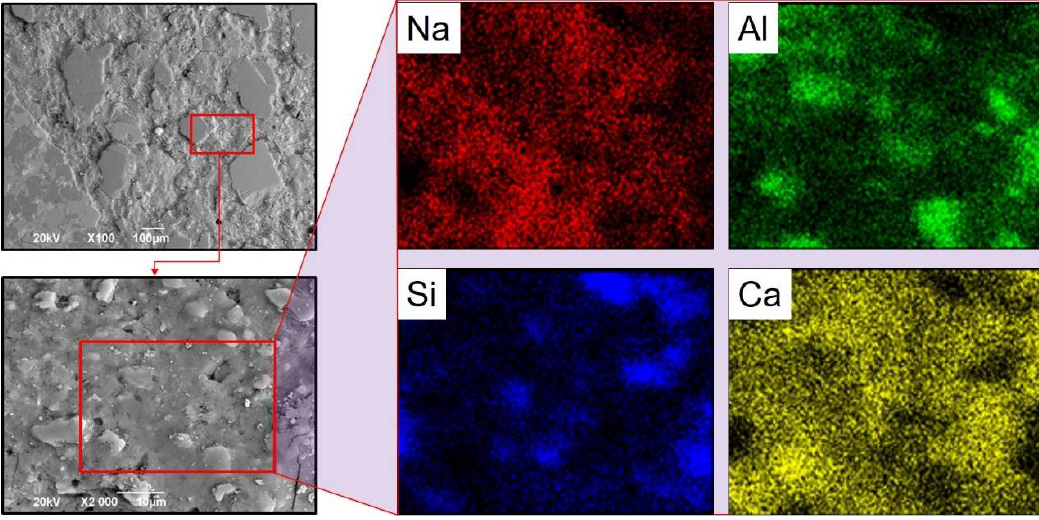
Figure 12. Composition and microstructural analysis (elemental chemical composition (EDS)-SEM) of the hybrid concrete.